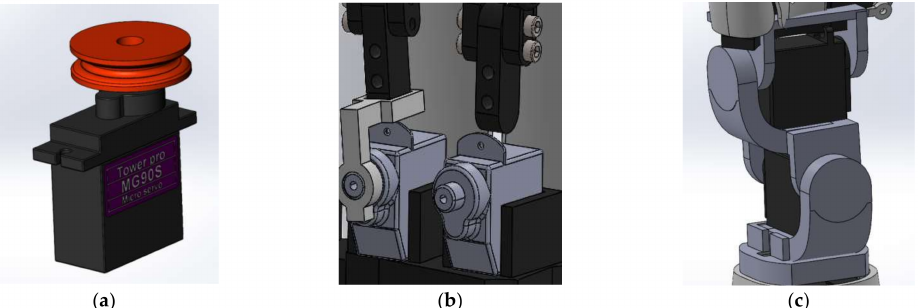
Figure 3. The main mechanical blocks of the projected robotic arm: ( a ) a mechanism for converting the rotational movement of the drive into linear; ( b ) a mechanism for finger extension and flexion; ( c ) a wrist mechanism.